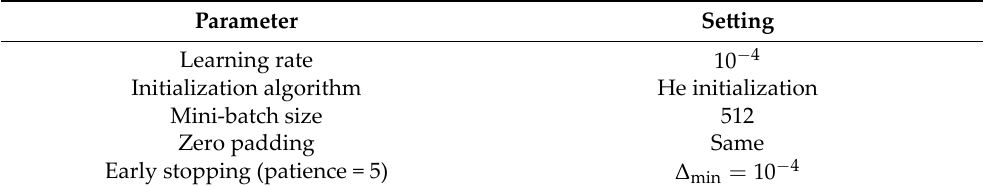
Table 3. Conv1D autoencoder hyperparameter settings.